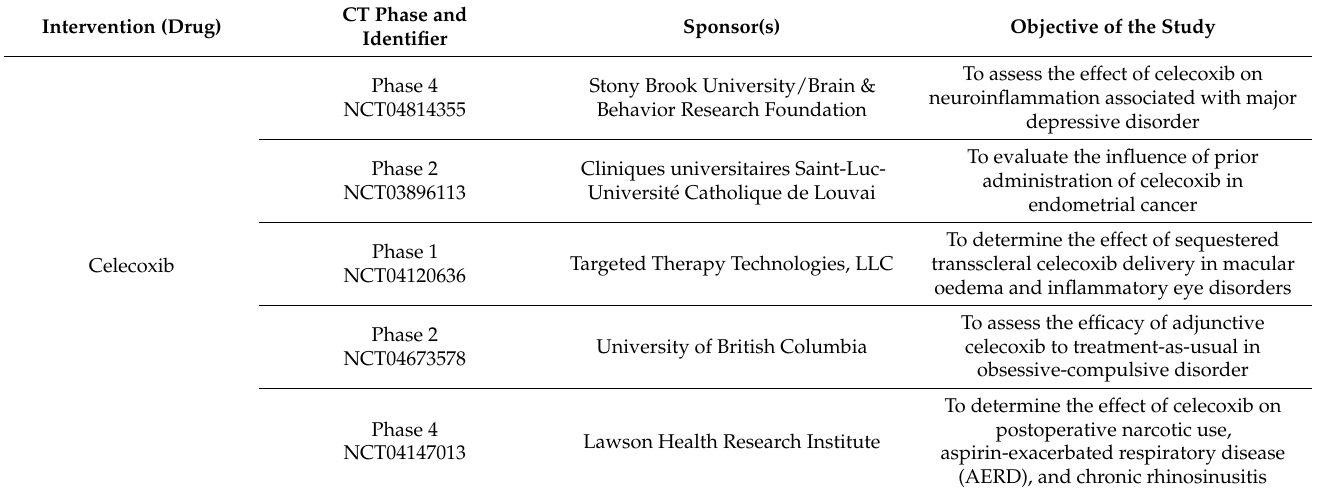
Table 1. A list of currently recruiting clinical trials including celecoxib, rofecoxib, and etoricoxib in the intervention